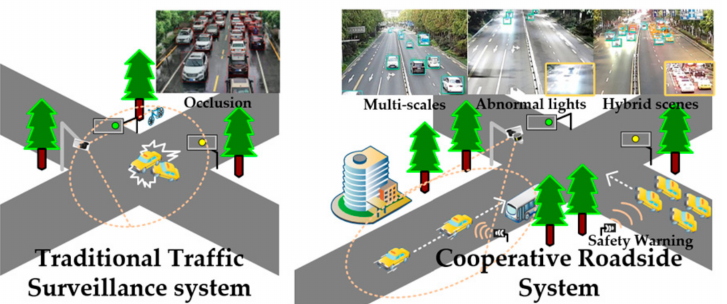
Figure 1. The differences between the traditional traffic management devices and the cooperative roadside system. While the traditional algorithms in traffic management devices concentrate on the occlusion scenarios, the ones in cooperative systems pay attention to the multi-scales and the robust detection ability towards the adverse